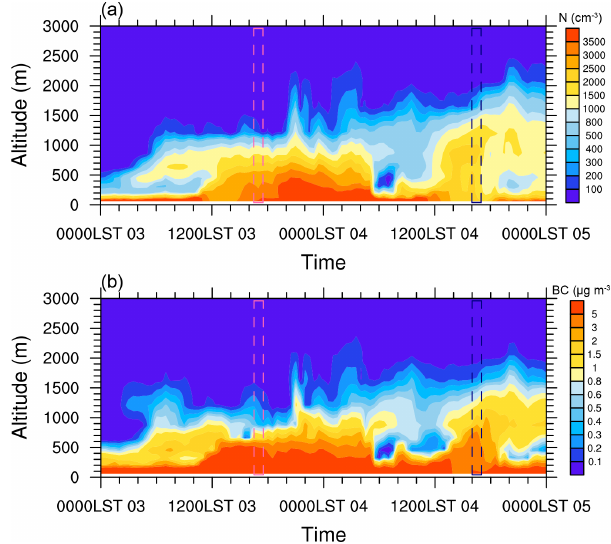
Figure 7. Temporal evolution of the EXP_Ctrl simulated aerosol vertical distributions over Baoding. (a) The aerosol number con- centration (particle diameter of 0.15–2.5µm). (b) The BC concen- tration. The pink and blue dashed boxes correspond to the aircraft observation periods on 3 and 4 January,